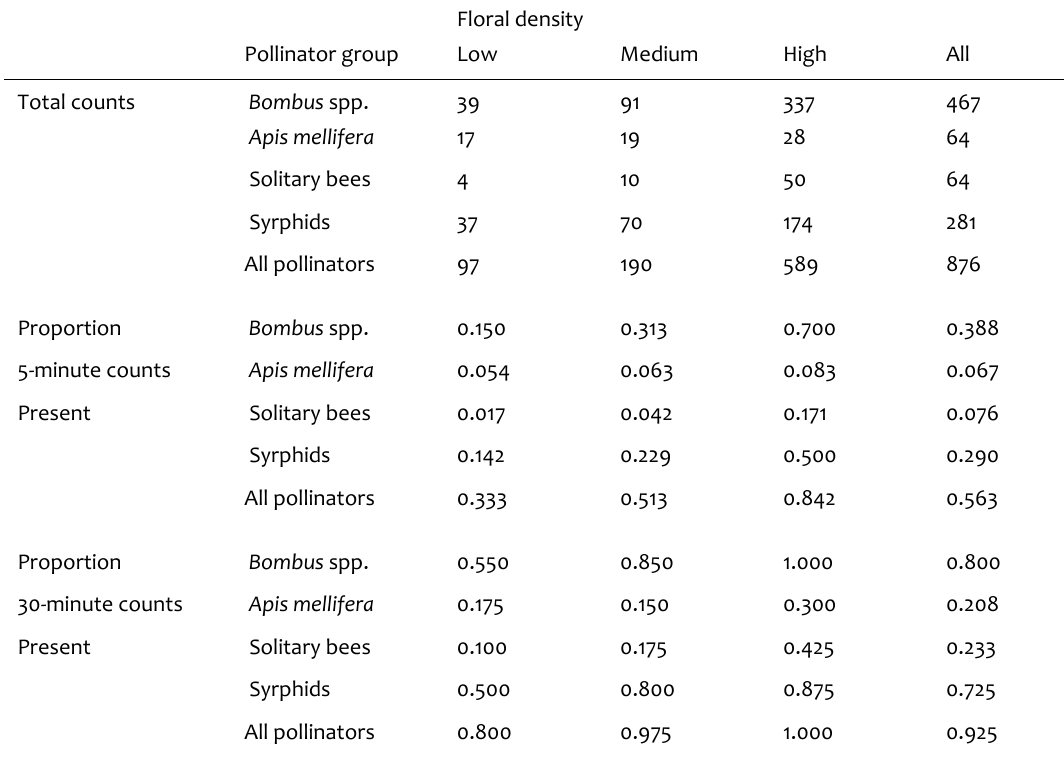
Table 1. Summary of timed surveys of four pollinator groups ( Bombus spp., Apis mellifera , solitary bees, Syrphidae) at Rosemount Orchard, Dublin in 2 x 2 m plots with low, medium, and high densities of floral units. Counts were obtained over forty 30-minute timed pollinator counts at each floral unit density. Proportion of surveys of duration 5-minutes (n = 240 per density) and 30- minutes (n = 40 per density) when each pollinator group was recorded is also